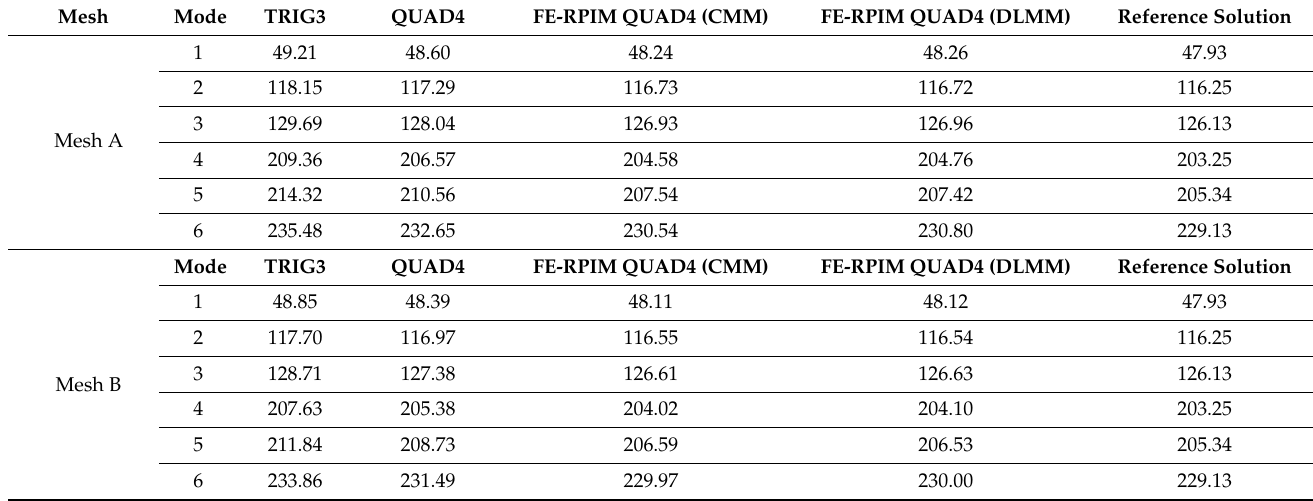
Figure 17. Triangular mesh for the plate with four holes. ( a ) Mesh A (1584 elements and 871 nodes); ( b ) Mesh B (2350 elements and 1278 nodes); ( c ) Mesh C (3170 elements and 1710 nodes); ( d ) Mesh D (5302 elements and 2814 nodes). Table 4. Comparisons of computed frequencies (Hz) for the plate with four